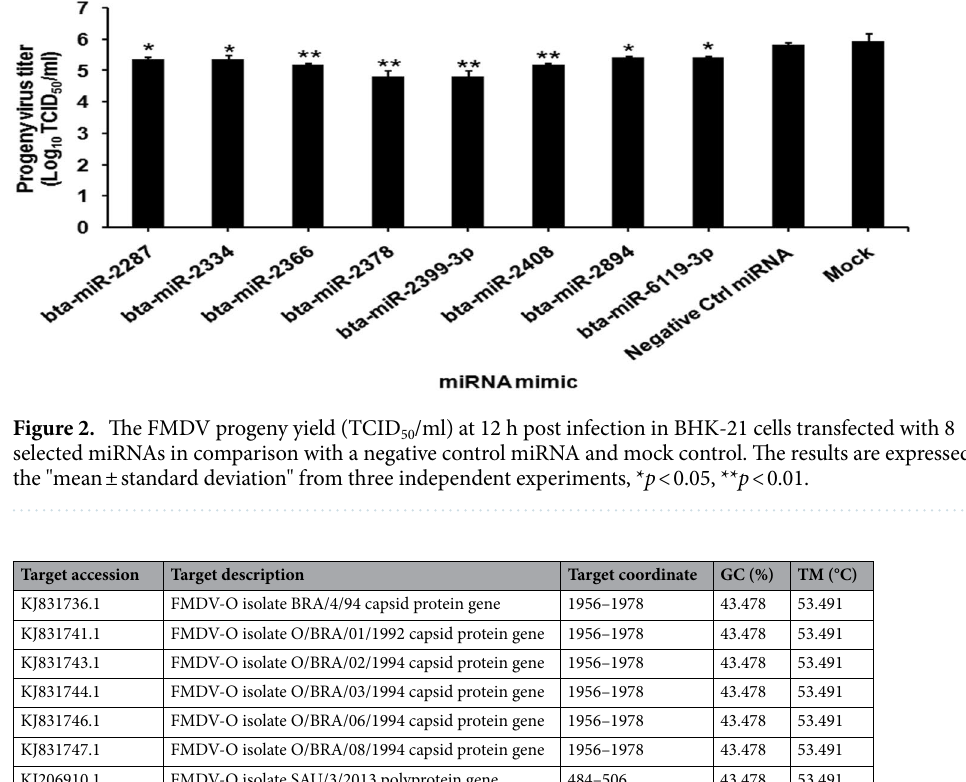
Table 5. Targetable regions of FMDV accessions having all favorable positional occurrences/non-occurrences of nucleotides.